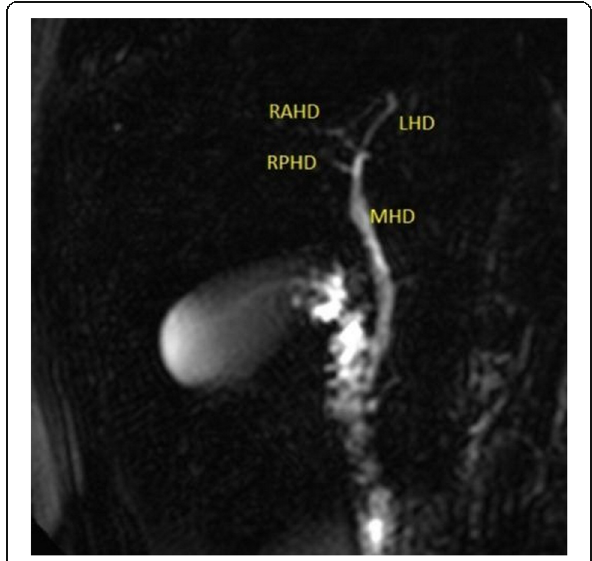
Fig. 6 MRC (RARE). Huang type A4: RPHD opens into main hepatic